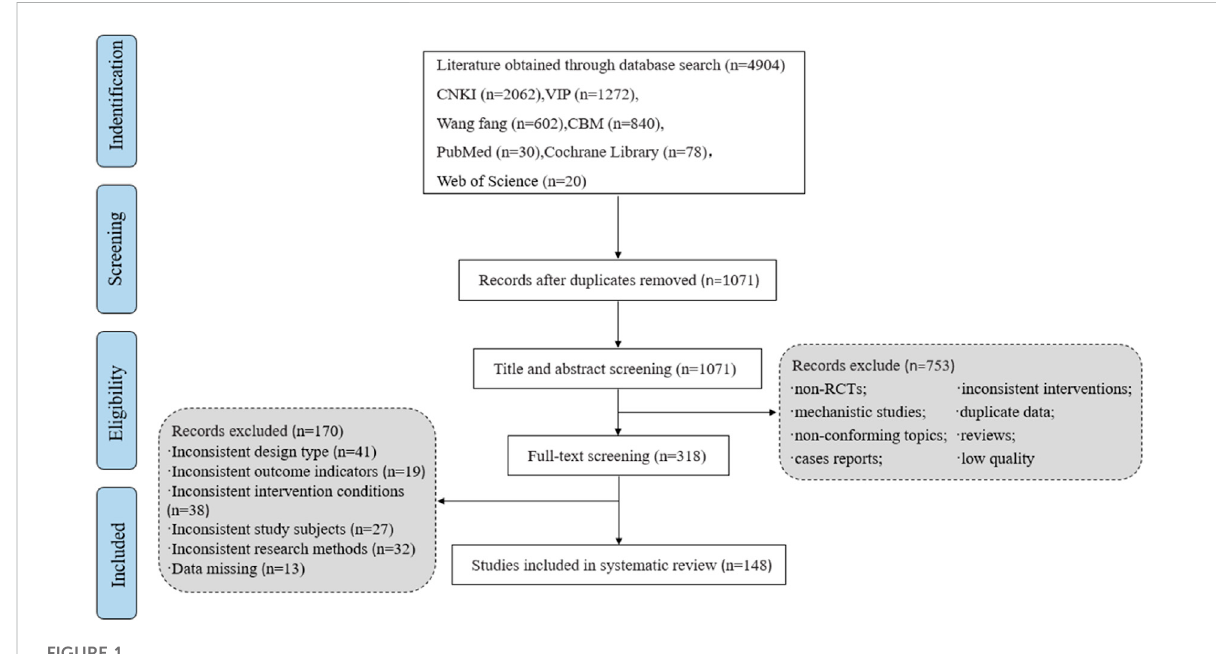
FIGURE 1 Flowchart of study